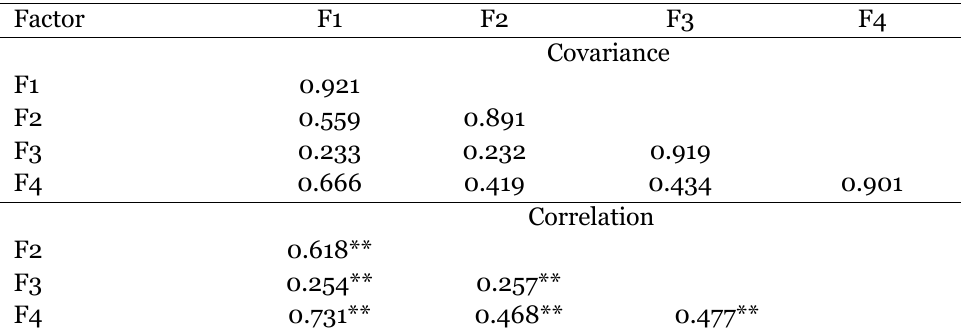
Factor Covariances and Correlations